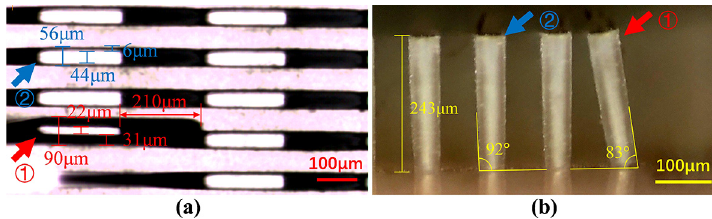
Figure 7. ( a ) Optical detection image of the tilted structure, and ( b ) microscopic side view of the same structures.